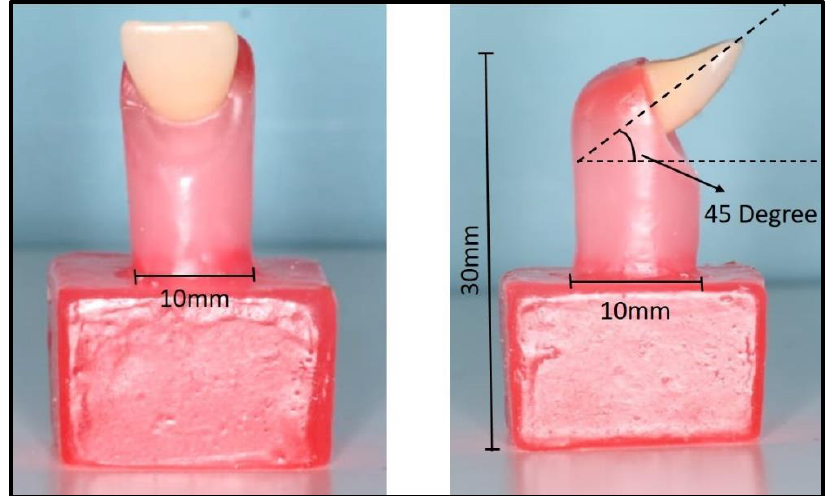
Figure 1. Acrylic tooth attached to the block with the long axes aligned at 45° with respect to the base of the block.